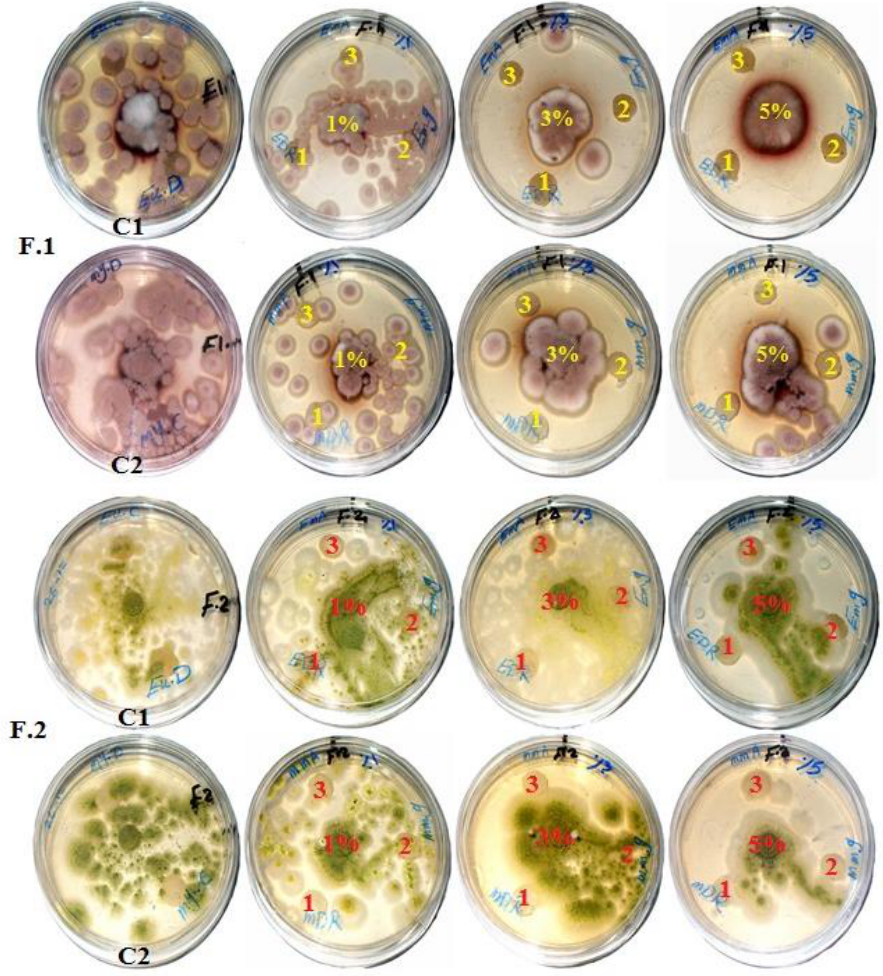
Figure 2. Fungal growth 14 days after inoculation and incubation of pulp paper discs produced with three HeOEs as additives. C1: Control of paper discs from E. camaldulensis treated with 10% DMSO; C2: control of paper discs from M. sinclairii treated with 10% DMSO; F1: A. terreus (first and second rows); F2: A. flavus (third and fourth rows); 1: HeOE of S. alba seeds; 2: HeOE of M. grandiflora leaves; 3: HeOE of M. azedarach fruits.